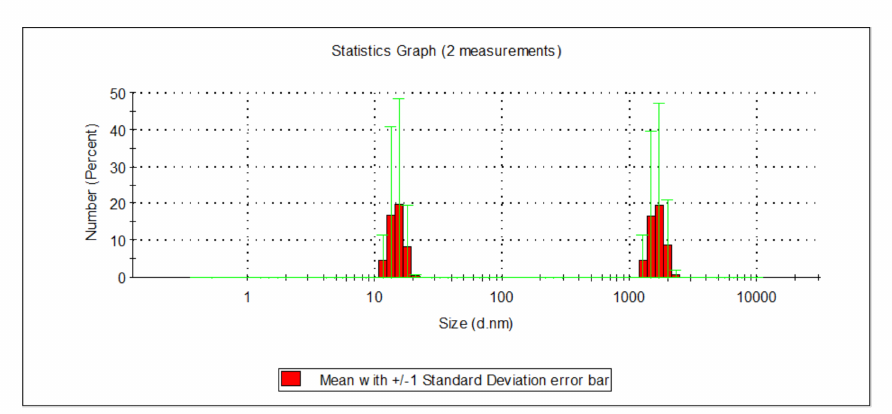
Figure 4. Distribution of particles in water following the PAXXL10 coagulation process.